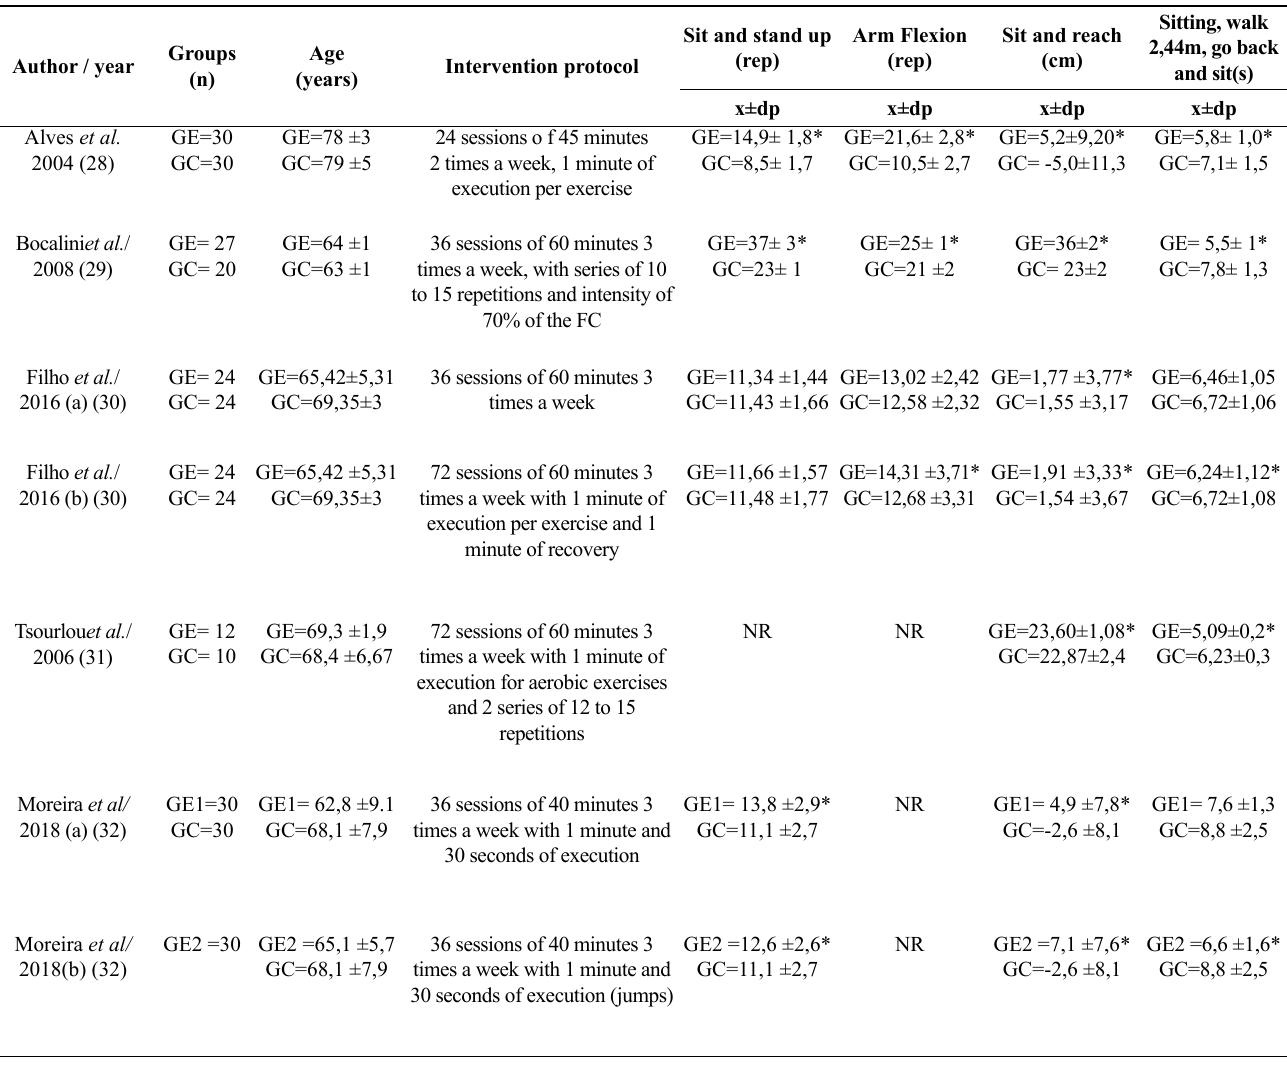
Table 1. Data extracted from included studies